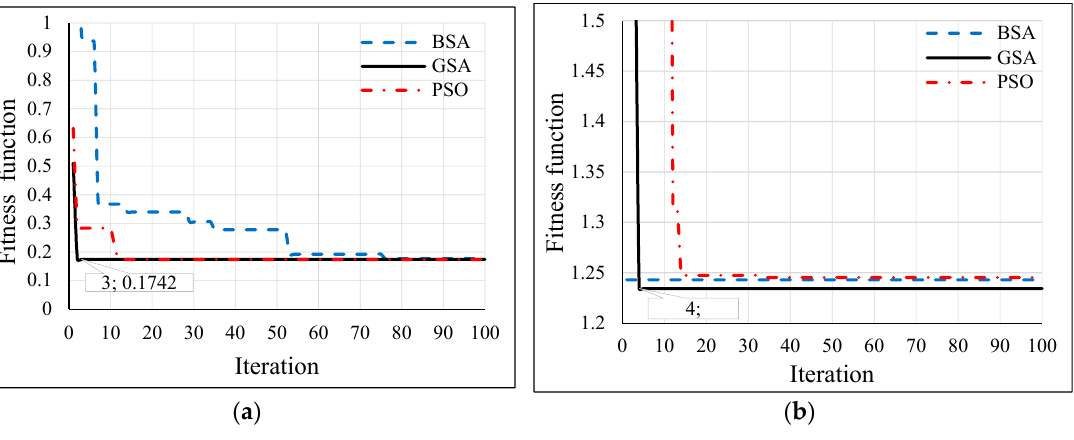
Figure 16. Fitness function comparison of GSA, PSO, and BSA for ( a ) outdoor and ( b ) indoor velodromes. Table 3. Neurons in each hidden layer and learning rate of ANN based on heuristic algorithms for different population sizes.